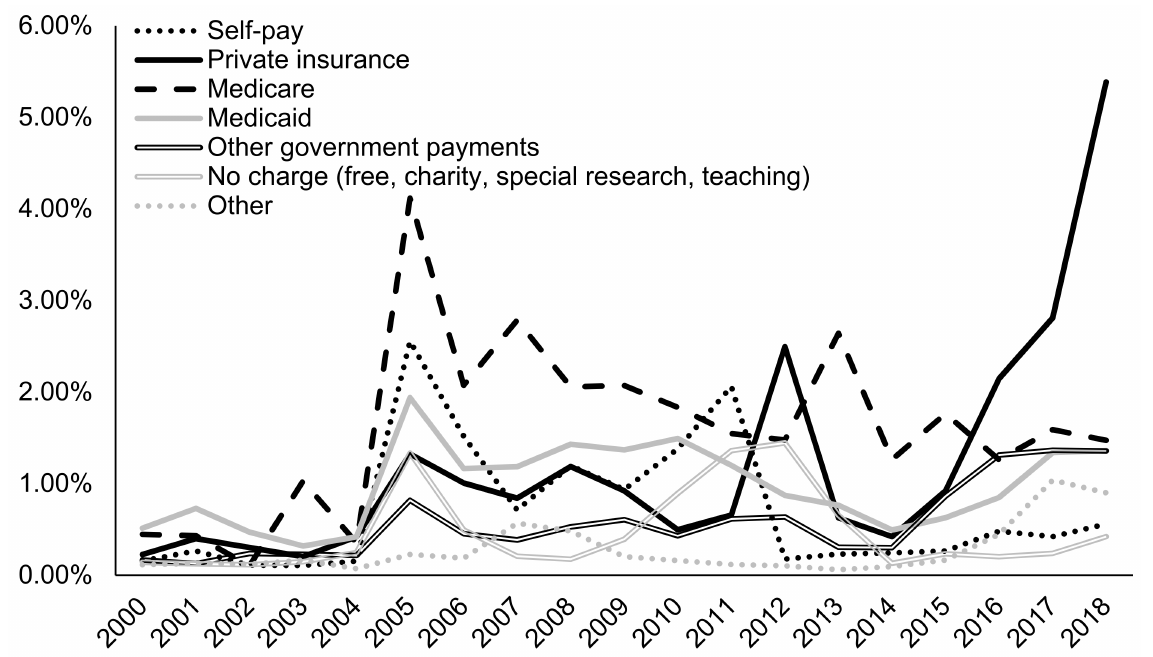
Figure 9. Prevalence of naltrexone treatment prescribed in alcohol use disorder (AUD) admissions from 2000–2018 by primary source of payment for treatment using TEDS-A data. Temporal trends were significant by the Cochran–Armitage trend test ( p < 0.0001).